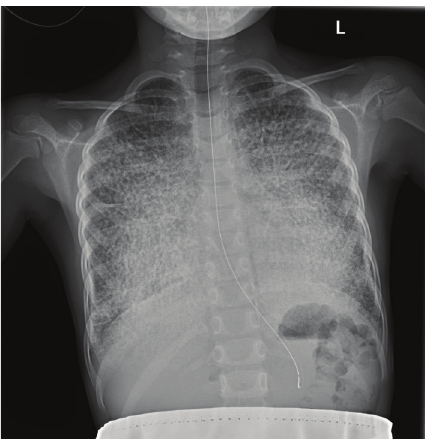
Figure 1: PA chest